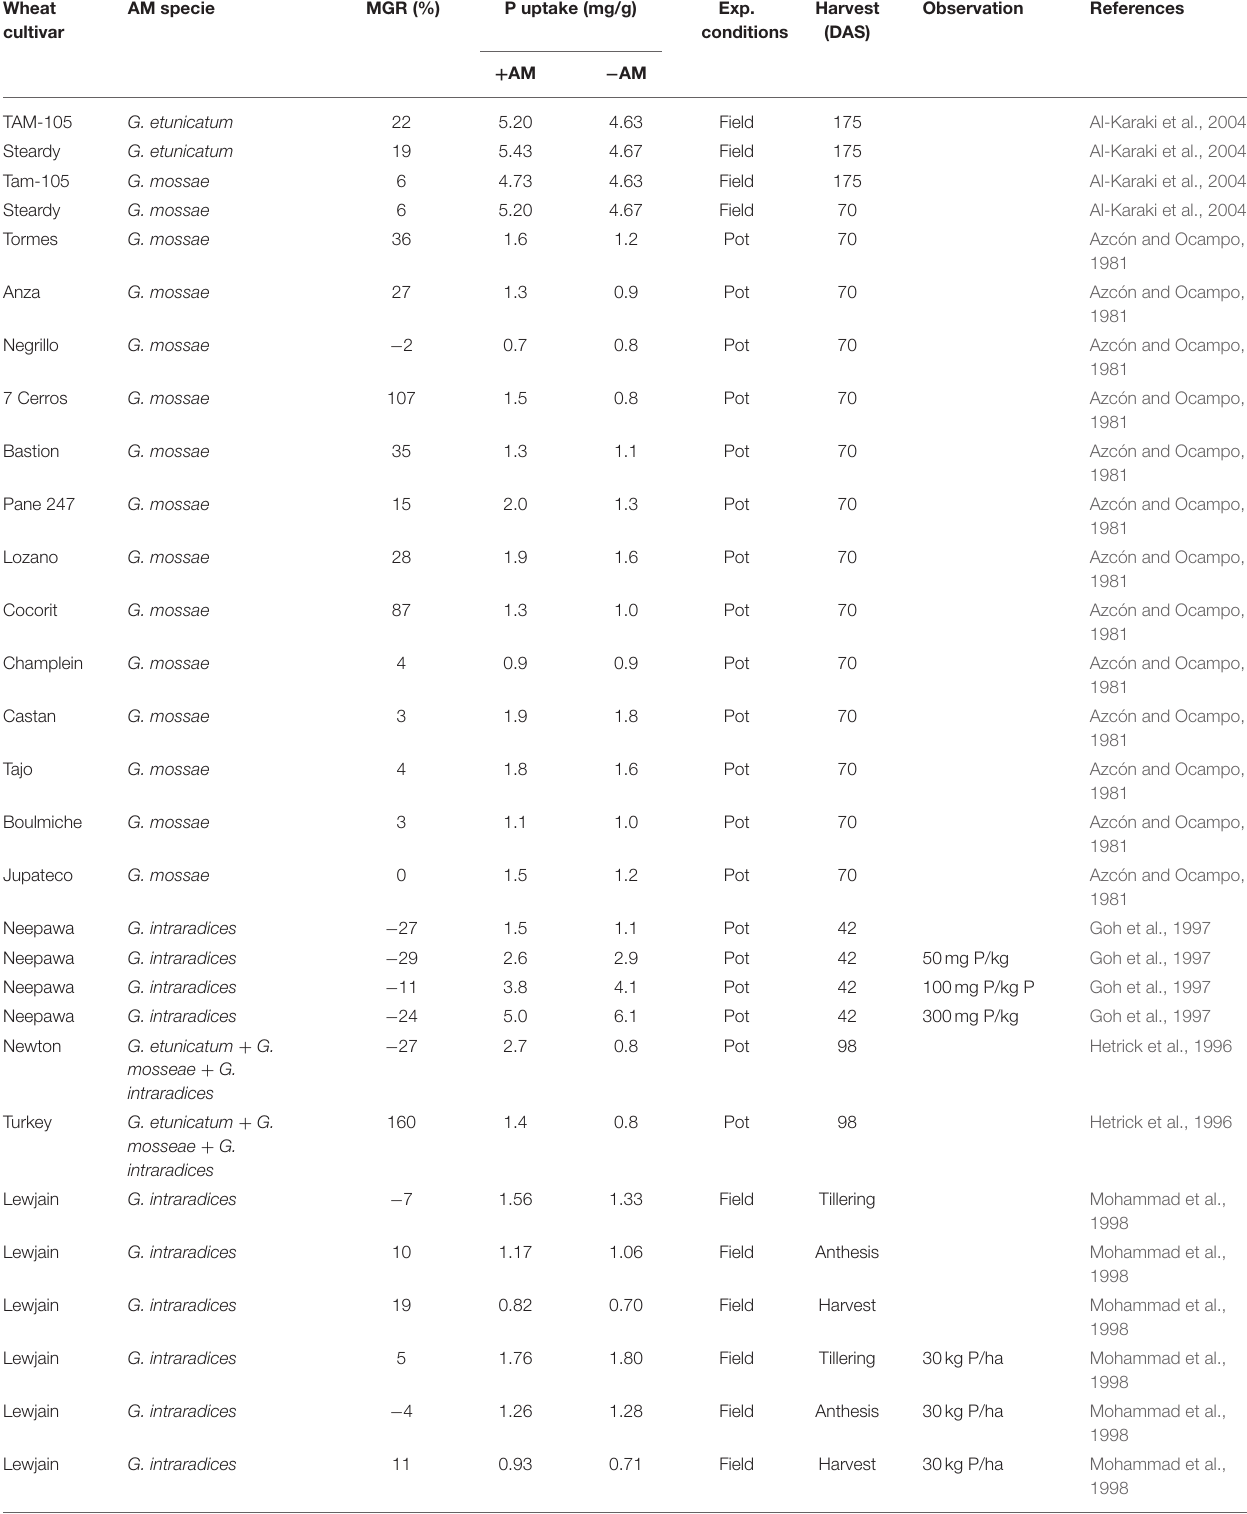
Table 1A | Mycorrhizal growth responses (MGR) and P uptake on mycorrhizal ( + AM) and non-colonized (–AM) wheat ( T. aestivum L.) cultivars under greenhouse or field conditions and at different days after sowing (DAS). Wheat AM specie cultivar